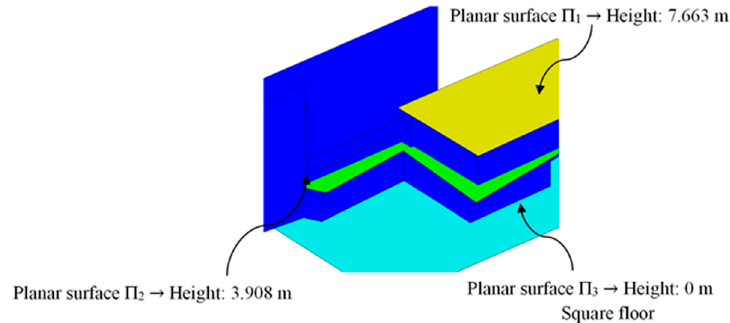
Figure 7. Definition of the flat surfaces that define the geometric boundary conditions of the BIM construction elements.